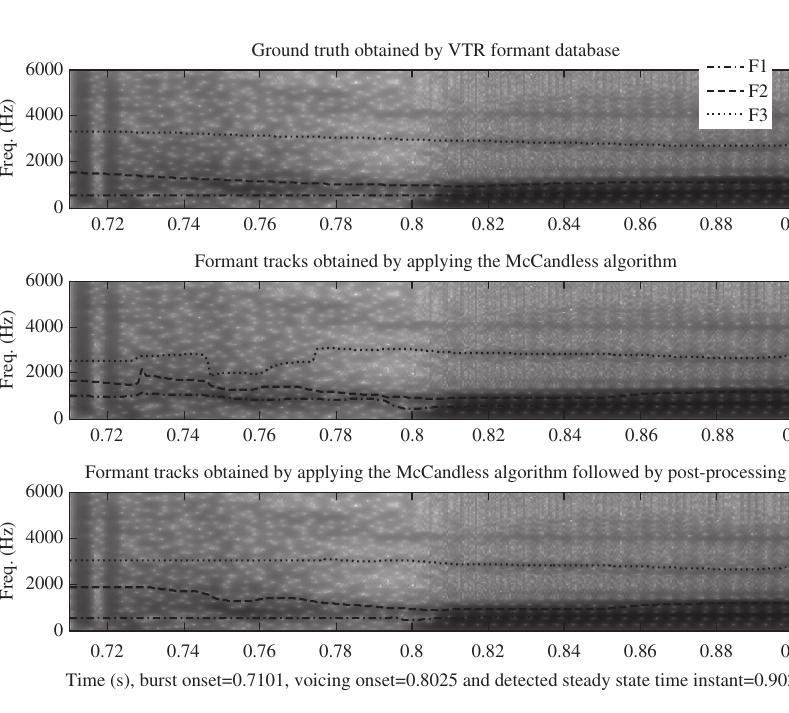
Figure 2. Ground Truth, Formant Tracks Obtained by Applying the McCandless Algorithm Before and After Post-Processing for the CV Syllable